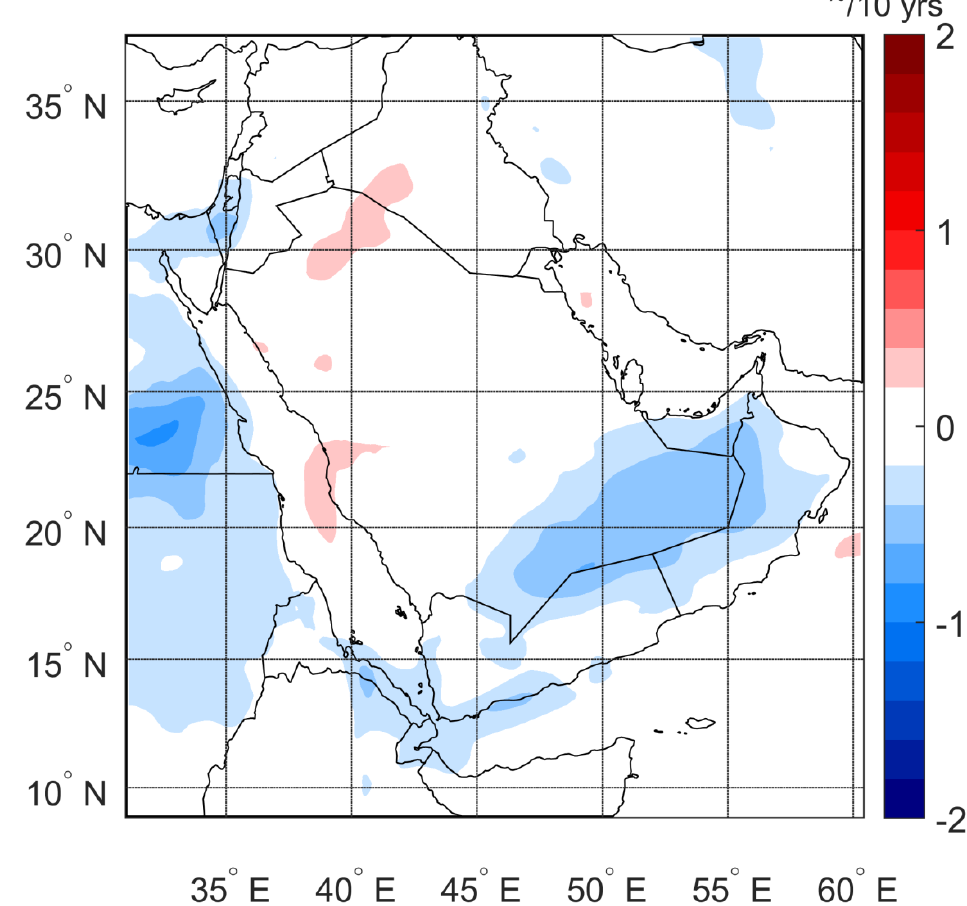
Figure 10. Annual accumulated precipitation (modeled) change (percentage) per 10 years.